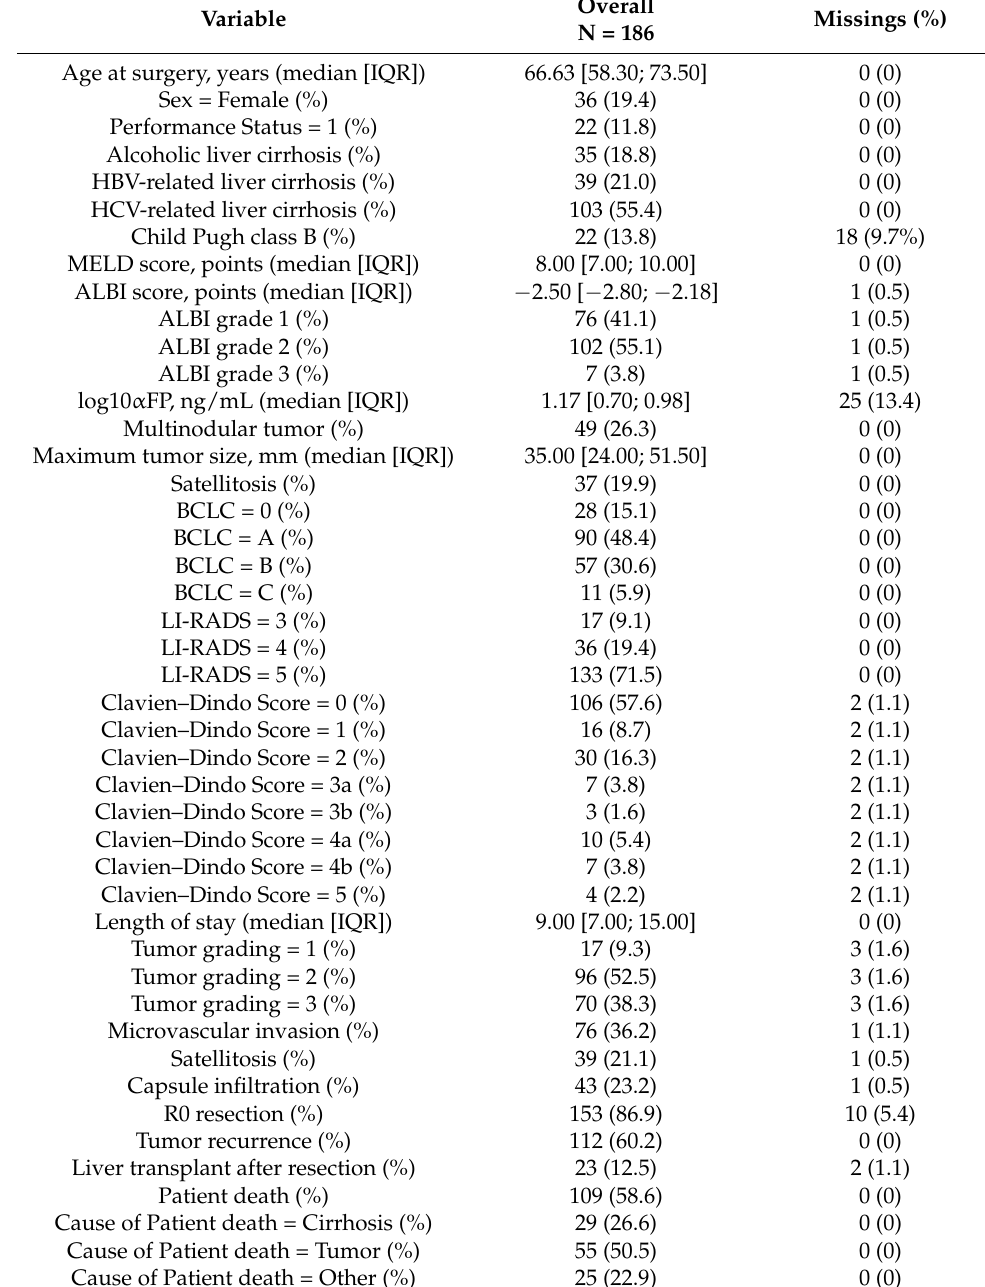
Abbreviations: MELD, Model for End Stage Liver Disease; HBV, Hepatitis B Virus; HCV, Hepatitis C Virus; ALBI, Albumin-Bilirubin; α FP, alpha-fetoprotein; BCLC, Barcelona Clinic for Liver Cancer; LI-RADS, Liver Imaging Reporting and Data